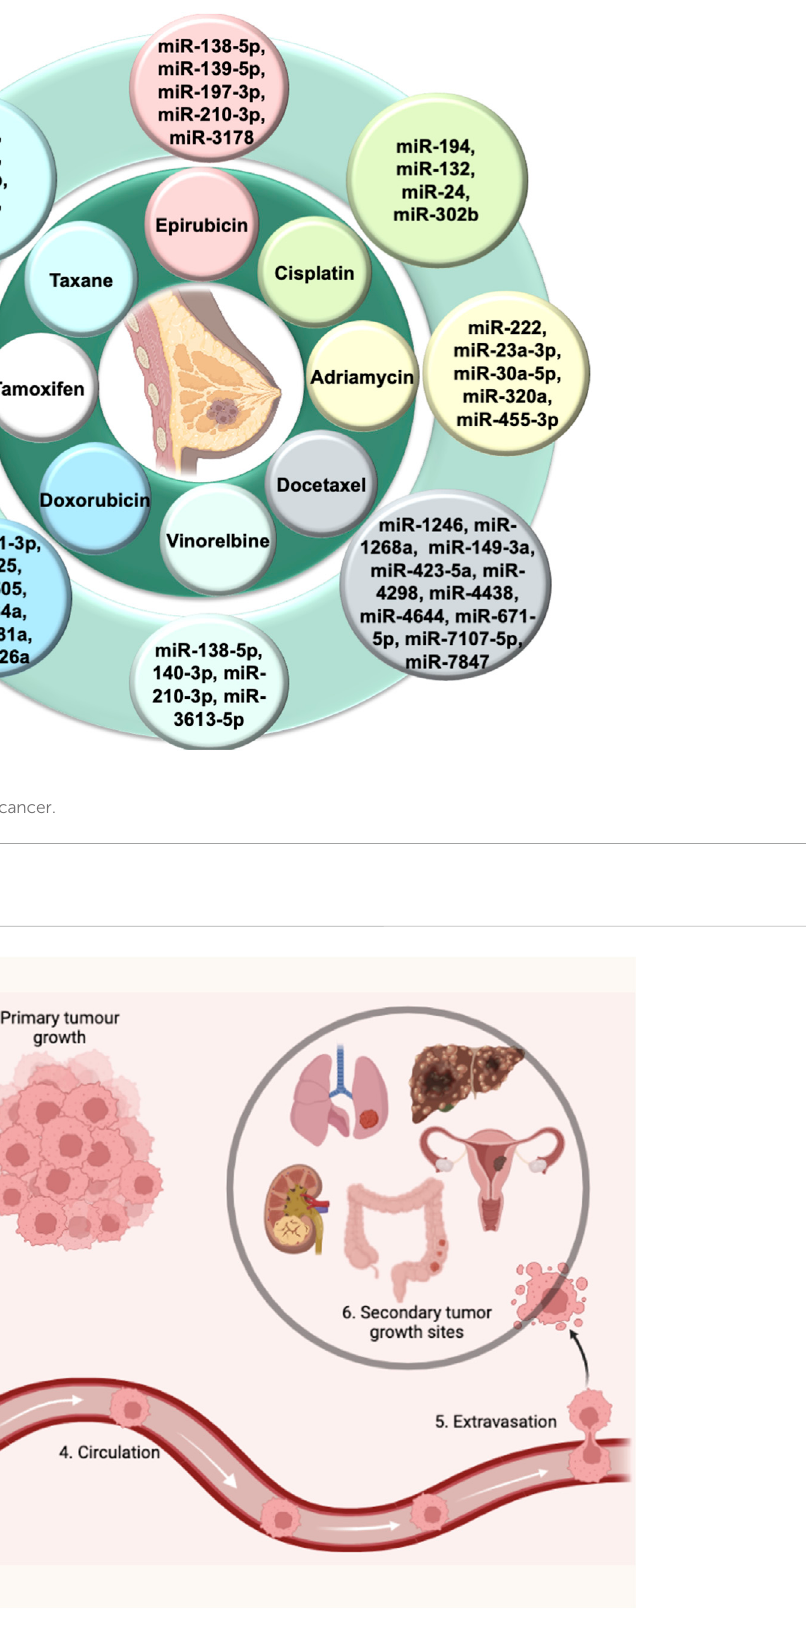
FIGURE 3 Illustrate the step of tumor growth into